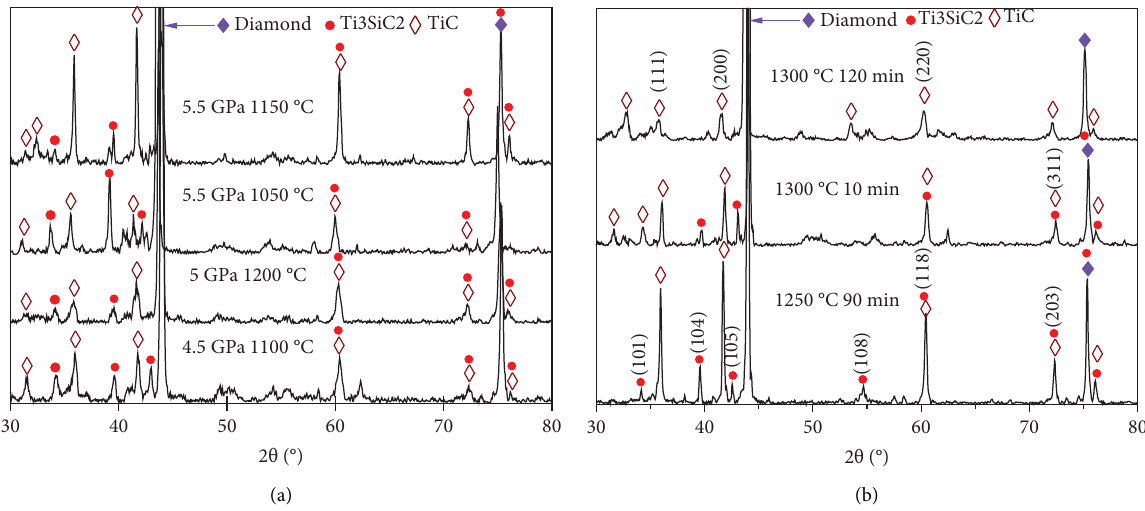
Figure 1: XRD patterns of Ti 3 Si 0.8 Al 0.2 C2–diamond (a) under 4.5–5.5GPa at 1050–1200